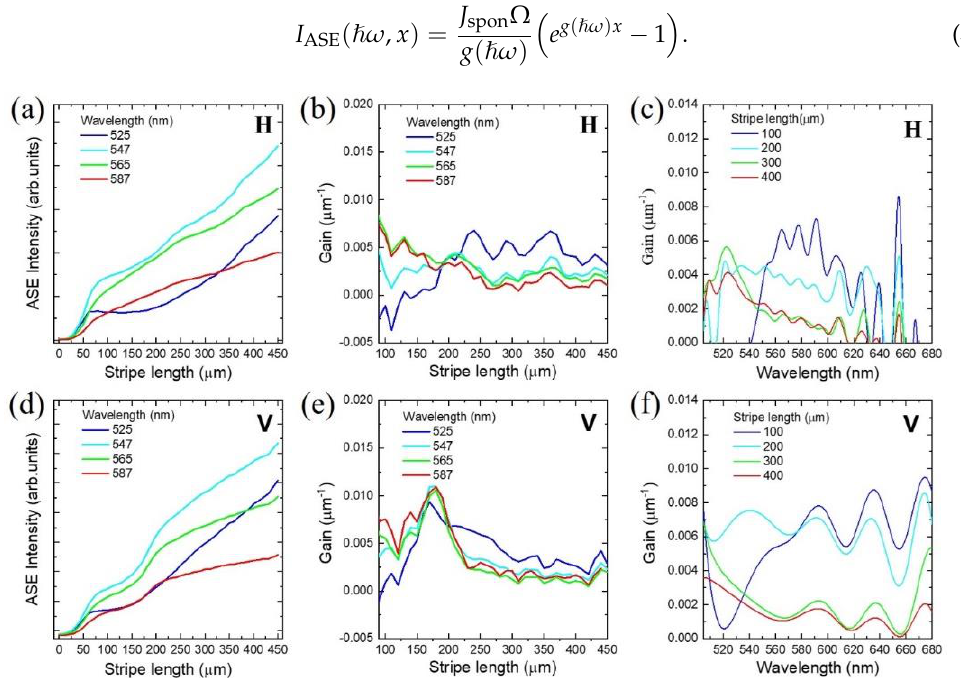
Figure 3. For selected wavelengths of blue (525 nm), cyan (547 nm), green (565 nm), and red (587 nm), stripe length dependence of ( a , d ) ASE intensity and ( b , e ) gain were obtained for horizontally (H) and vertically (V) polarized excitation, respectively. ( c , f ) Gain spectrum obtained with H- and V-polarized excitation show a significant difference.